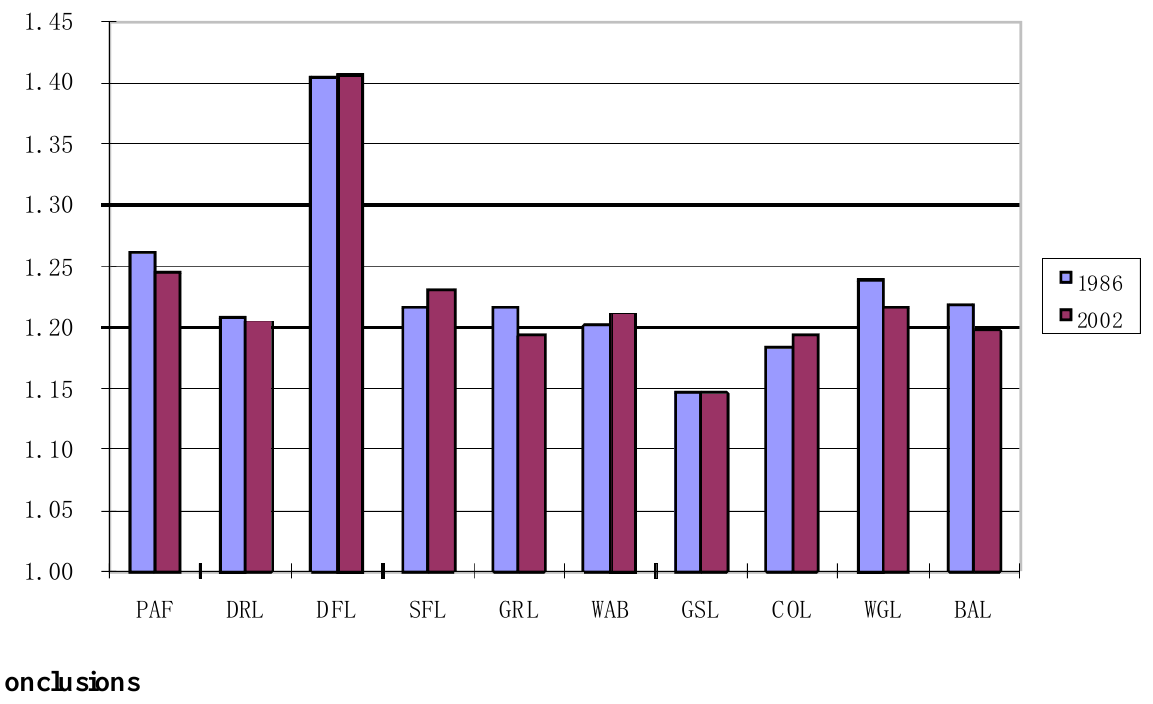
Figure 7. Change of AWMPFD at class level in Lijiang County during